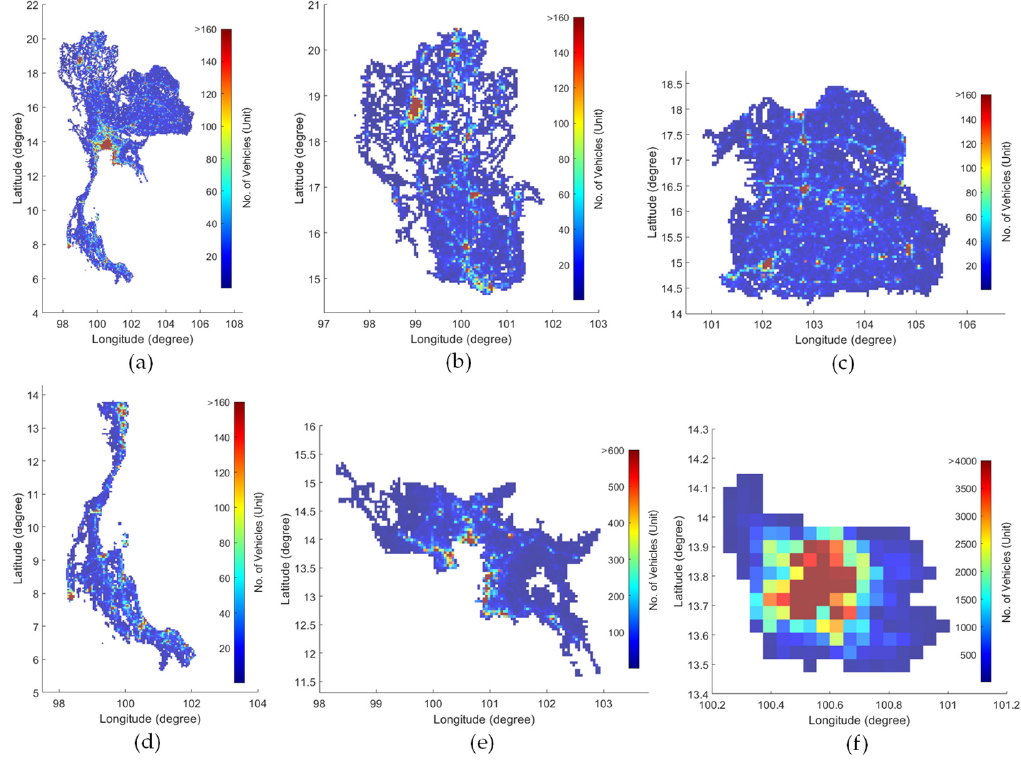
Figure 8. Heat maps representing the number of electric passenger cars ( ≤ 7 seats) in ( a ) Thailand, ( b ) Northern PEA, ( c ) Northeastern PEA, ( d ) Southern PEA, ( e ) Central PEA, and ( f ) MEA.